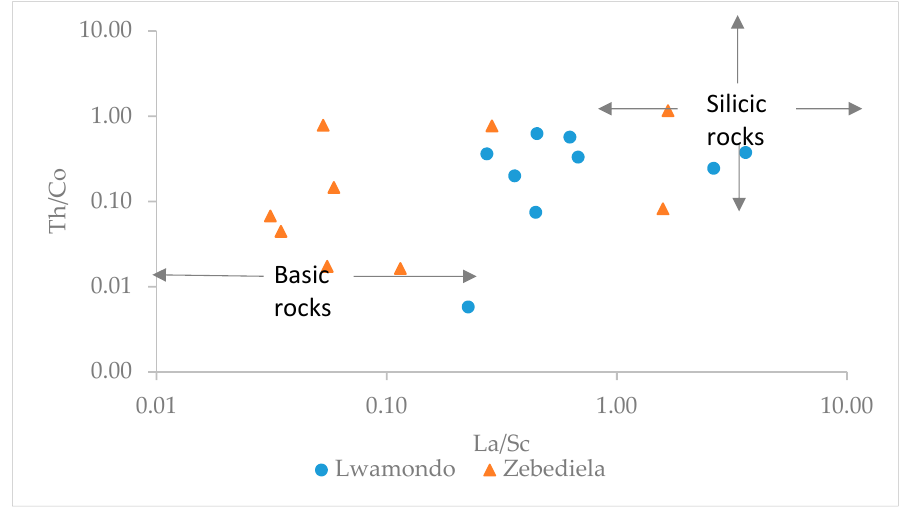
Figure 8. Th/Co vs. La/Sc showing the source rocks of the Lwamondo and Zebediela kaolins.